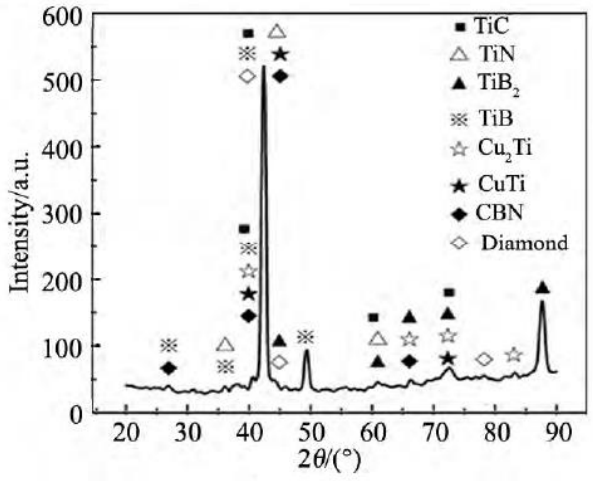
Figure 6. XRD profile at a brazing interface [19]. Reproduced with permission from Liu et al., Journal of Synthetic Crystals, 2015.